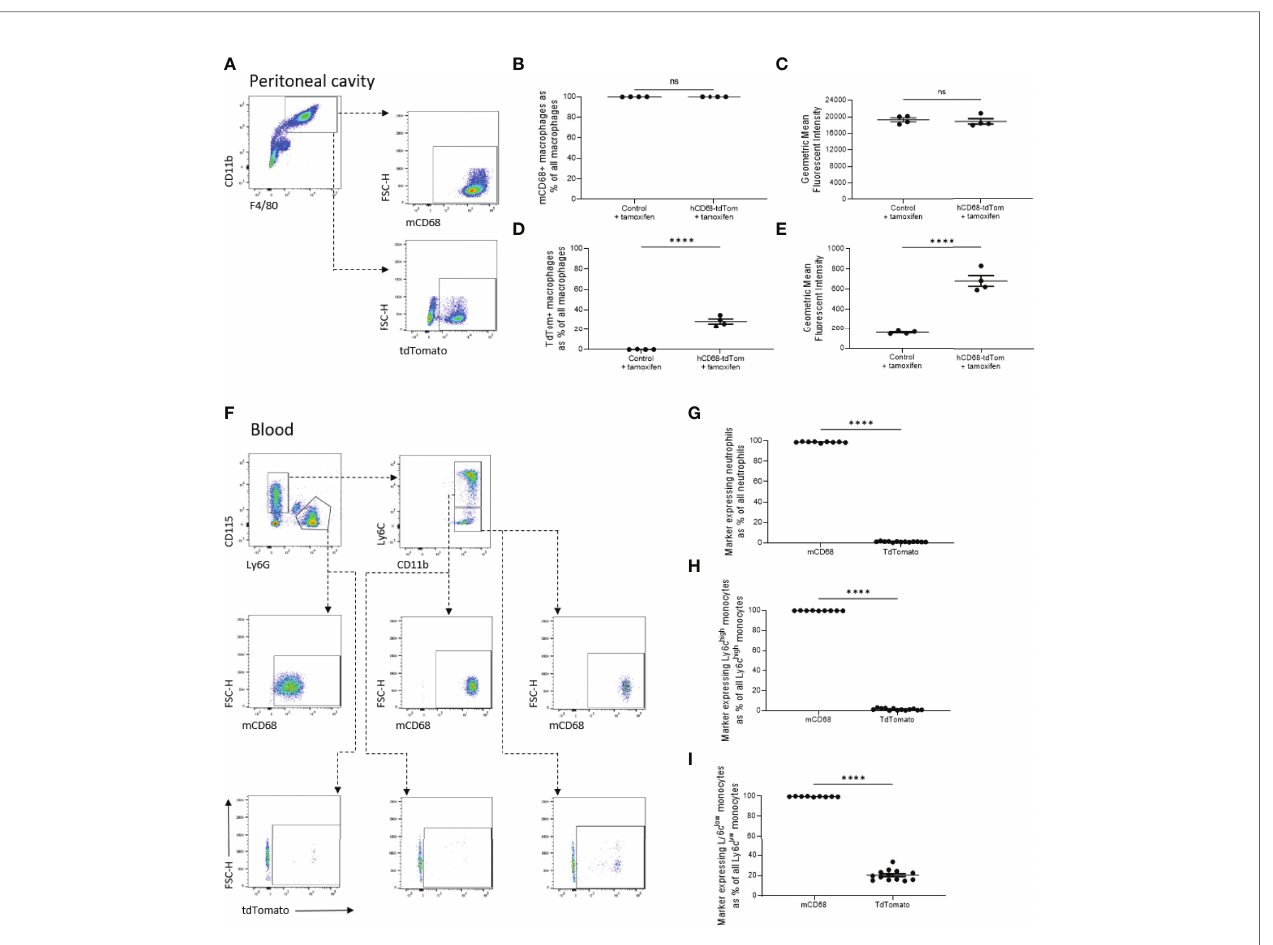
FIGURE 4 | The transgenic human CD68 promoter has higher macrophage speci fi city compared to endogenous murine Cd68 expression. (A) Representative dot plots of the gating strategy for peritoneal macrophages (CD11b + , F4/80 + ) and their expression of tdTomato and murine CD68 (mCD68). (B) Frequency of tdTomato- expressing peritoneal macrophages as a proportion of all peritoneal macrophages with corresponding mean fl uorescence intensity in (C) . (D) Frequency of mCD68- expressing macrophages as a proportion of all peritoneal macrophages with corresponding mean fl uorescence intensity in (E) . (F) Representative dot plots of the gating strategy for blood neutrophils (CD115 - , Ly6G + ), Ly6C high and Ly6C low monocytes (CD115 + , Ly6G - , Ly6C + and CD115 + , Ly6G - , Ly6C - respectively) and their expression of tdTomato and mCD68. (G) Comparison of frequency of neutrophils expressing mCD68 and tdTomato. (H) Comparison of frequency of Ly6C high monocytes expressing mCD68 and tdTomato. (I) Comparison of frequency of Ly6C low monocytes expressing mCD68 and tdTomato; for panels (G – I) mCD68 was quanti fi ed for control mice without tamoxifen, tdTom was measured for hCD68-tdTom + tamoxifen mice, student t-test (**** = p < 0.0001). ns, not signi fi